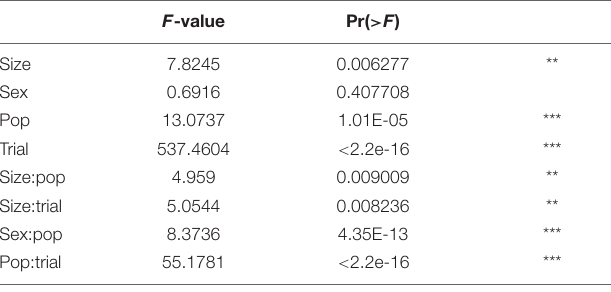
TABLE 1 | Type III Analysis of variance table with Satterthwaite’s method for emergence latency across populations.